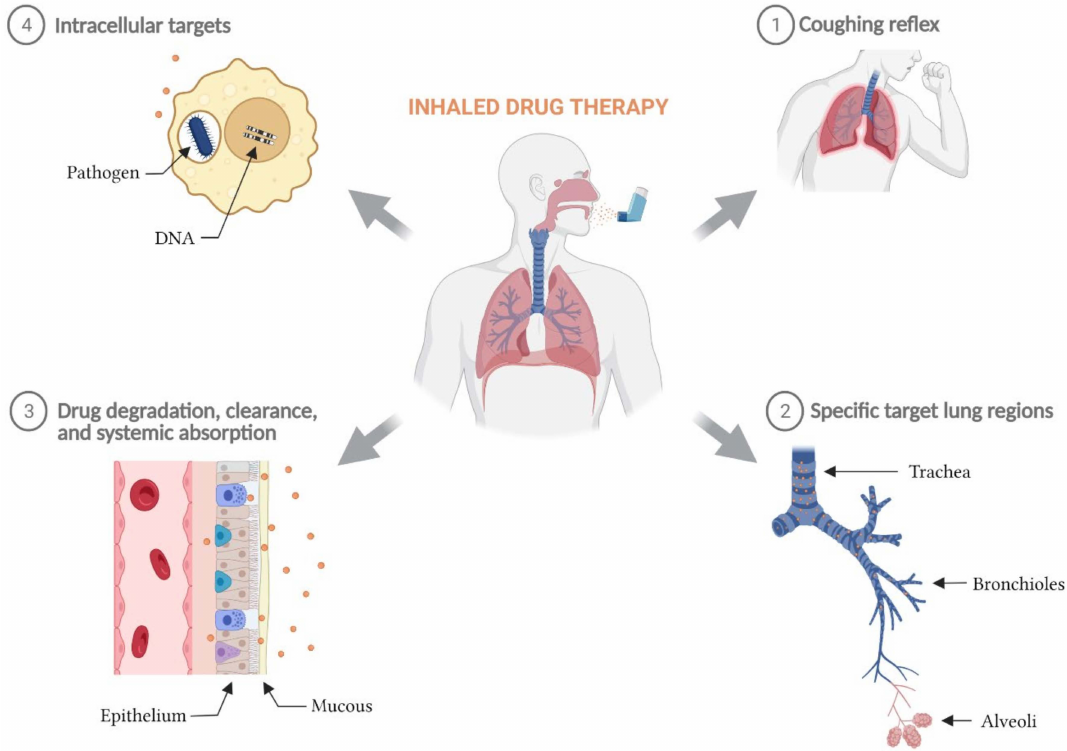
Figure 1. Biological barriers to inhaled drug therapy. The major biological barriers to a successful inhaled drug therapy include: ( 1 ) post-inhalation coughing reflex, ( 2 ) low delivery efficiency to specific target lung regions, ( 3 ) rapid elimination of inhaled active molecules from the lung via degradation, clearance, and/or systemic absorption, and ( 4 ) the inability for inhaled therapies with intracellular targets to sufficiently penetrate cellular phospholipid membranes and maintain therapeutic concentrations